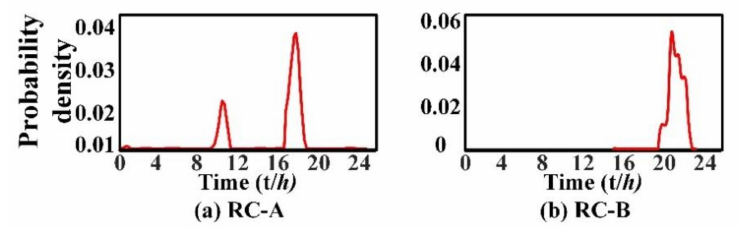
Figure 9. Load switching probability distribution curve for RC-A (a) and RC-B